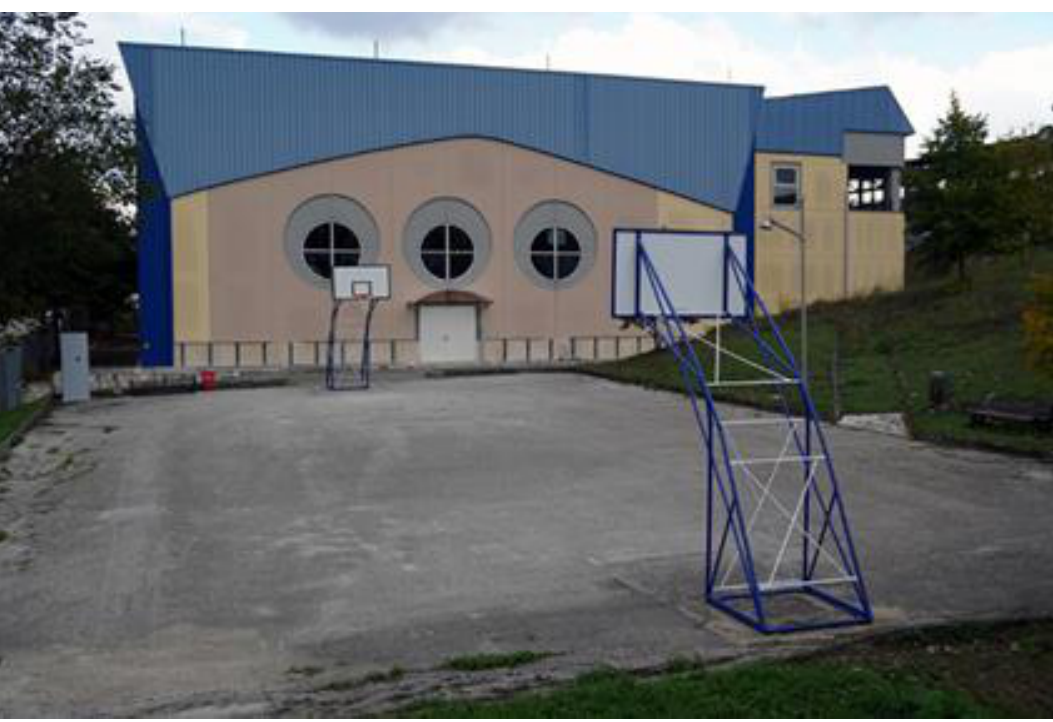
Figure 27. Lioni: the new sports facilities (photos by [35,36]).